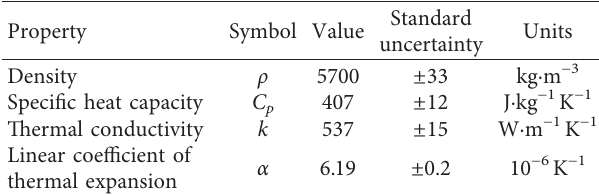
Table 1: CuCD RHP3434 material properties at room temperature.